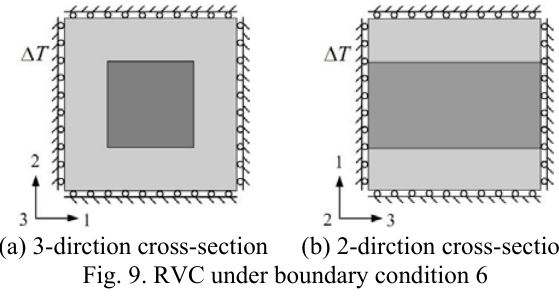
Fig. 9. RVC under boundary condition 6